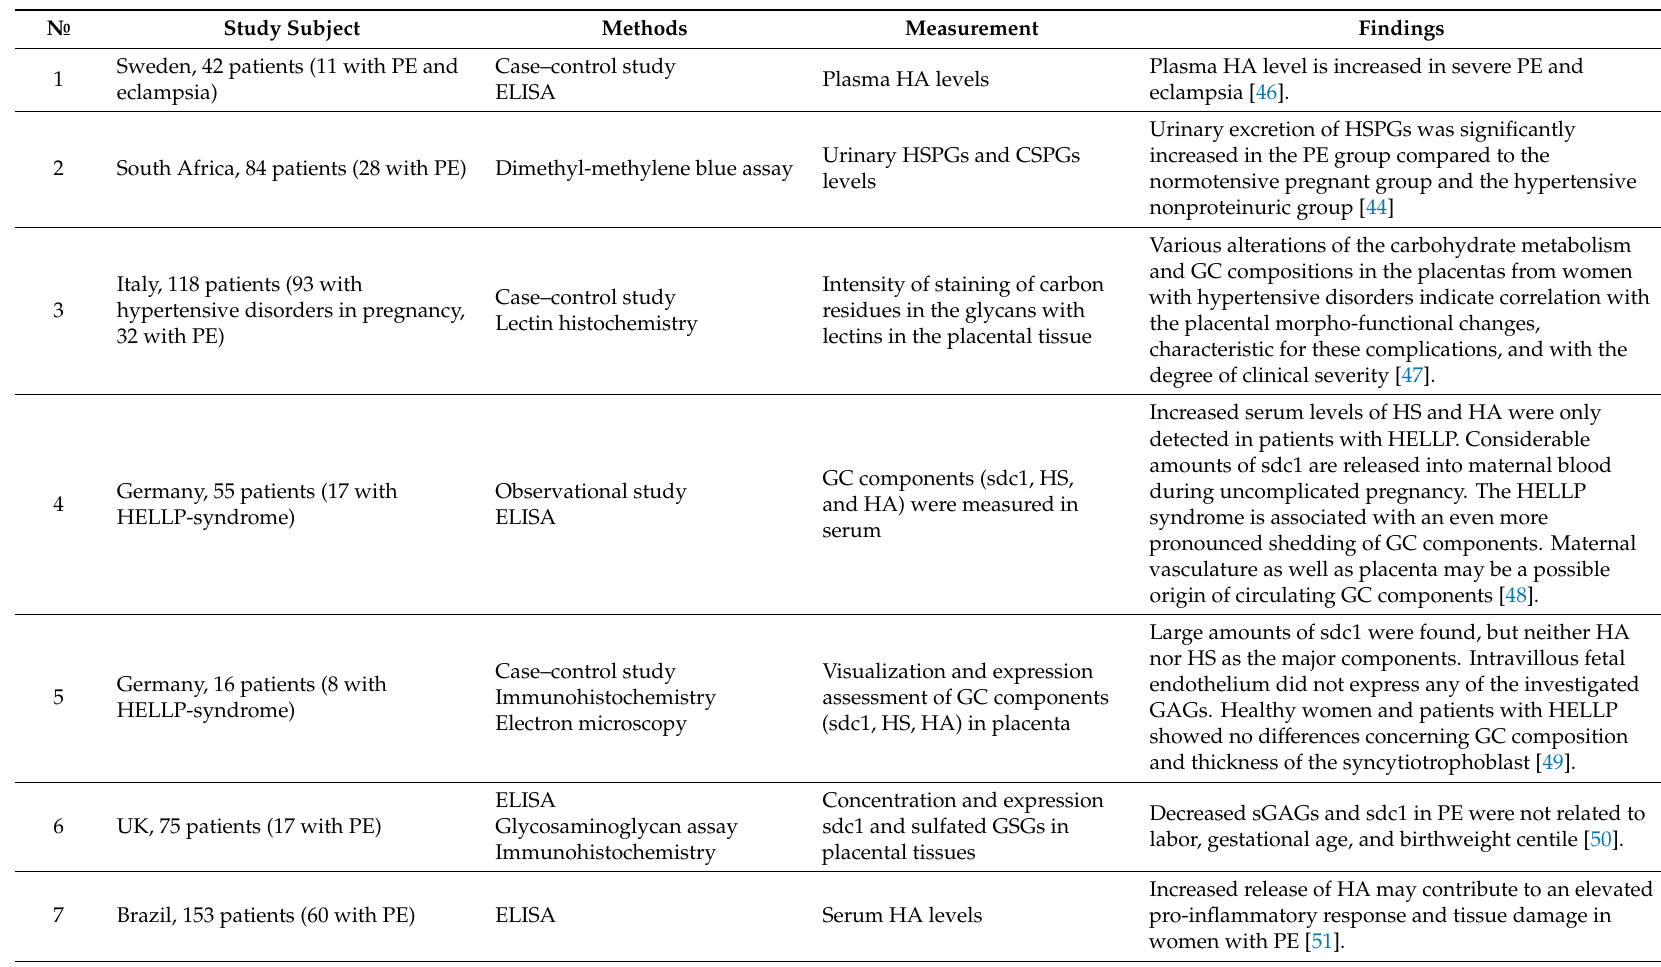
Table 2. Clinical and experiment research of glycocalyx and / or its components in